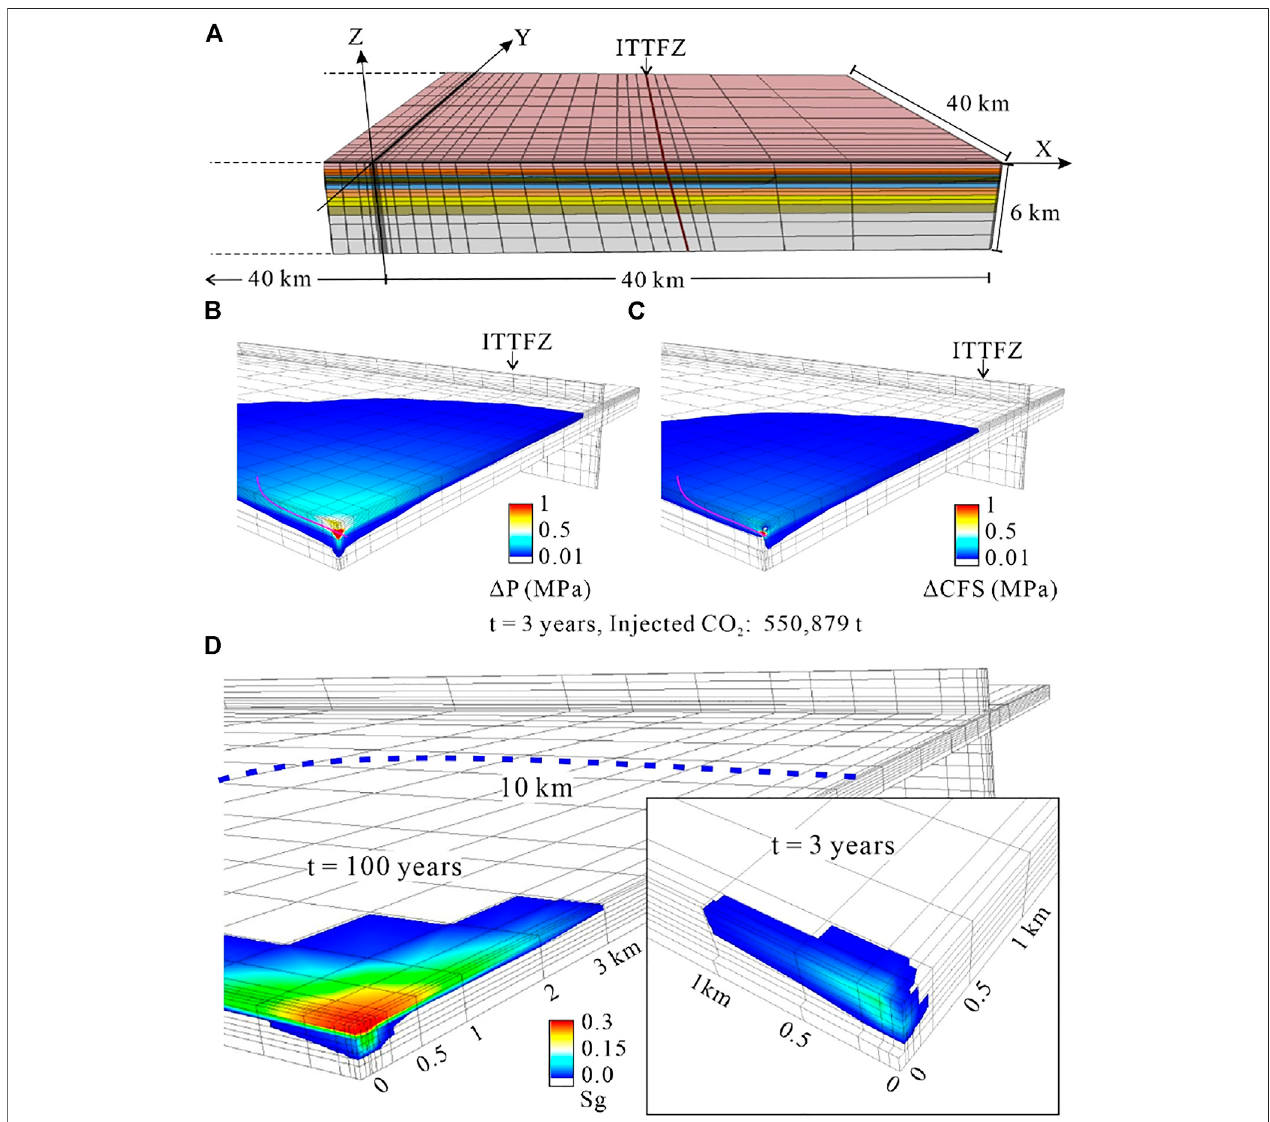
FIGURE4| Three-dimensionalnumericalmodel (A) ,pressure/CFSincreaseafterinjectionforthreeyears (B,C) ,anddistributionofCO 2 saturationafterinjectionfor three and 100 years (D) . Permeability of 50 mD and porosity of 0.15 were assumed for the injection layer.